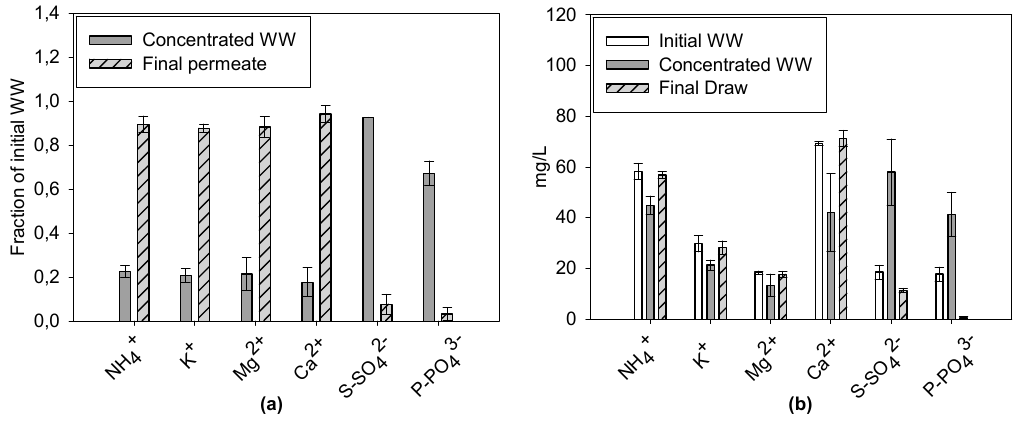
Figure 8. Average ion mass balance with standard deviation at the end of the test with real WW ( a ). Average ion concentrations with standard deviation of the test with real WW in the original WW, concentrated WW, and final permeate at the end of the test ( b ).